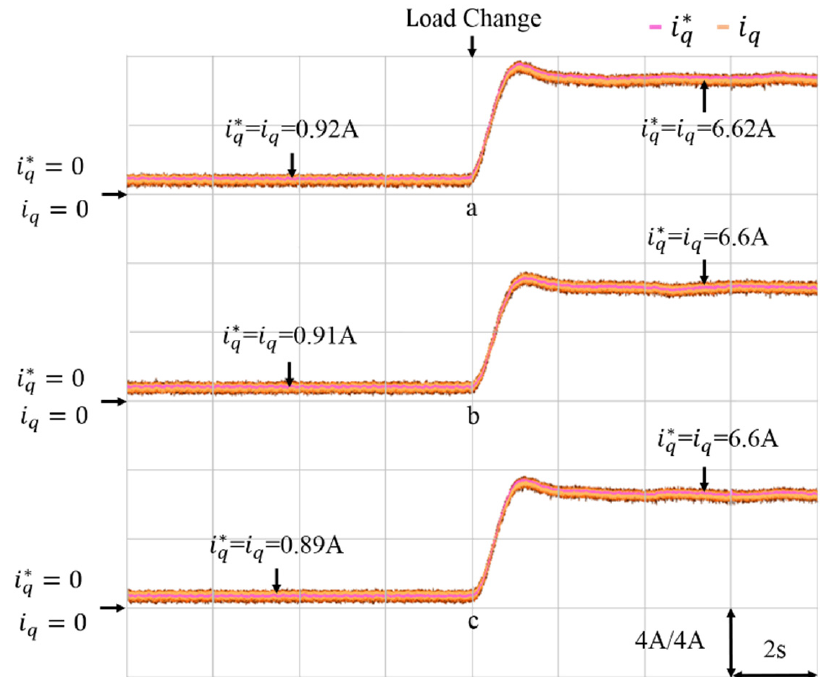
* i and i by using PI current controller from no load torque to 4.75 Nm at Figure 10. Measured Figure 10. Measured i ∗ q and i q by using PI current controller from no load torque to 4.75 Nm at q q 1000 rpm: ( a ) using PI current controller; ( b ) using PI-type SMC current controller; ( c ) using PID 1000 rpm: (a) using PI current controller; (b) using PI-type SMC current controller; (c) using PID neural network current neural network current controller.